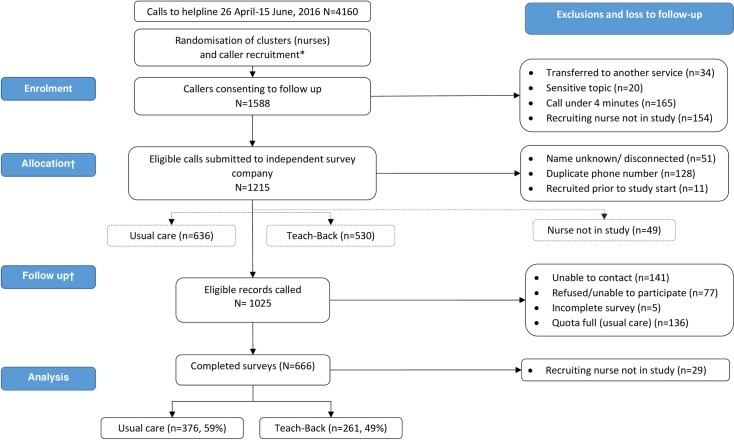
Flow chart of calls.